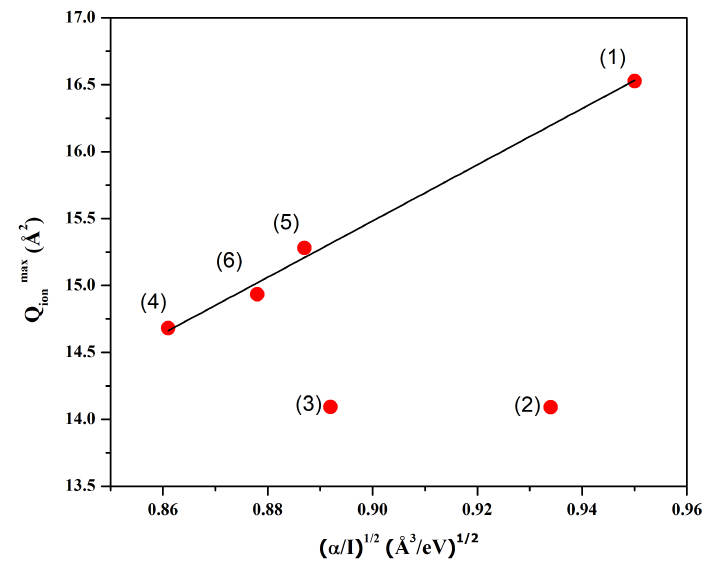
Figure 13. The correlation of Q max with ( α / I ) 1 2 for vinyl ether and its isomers. (1): vinyl ether, ion (2): 2-butenal, (3): cis-2-butenal, (4): cyclobutanone, (5): furan, 2, 3-dihydro, (6): furan, 2,